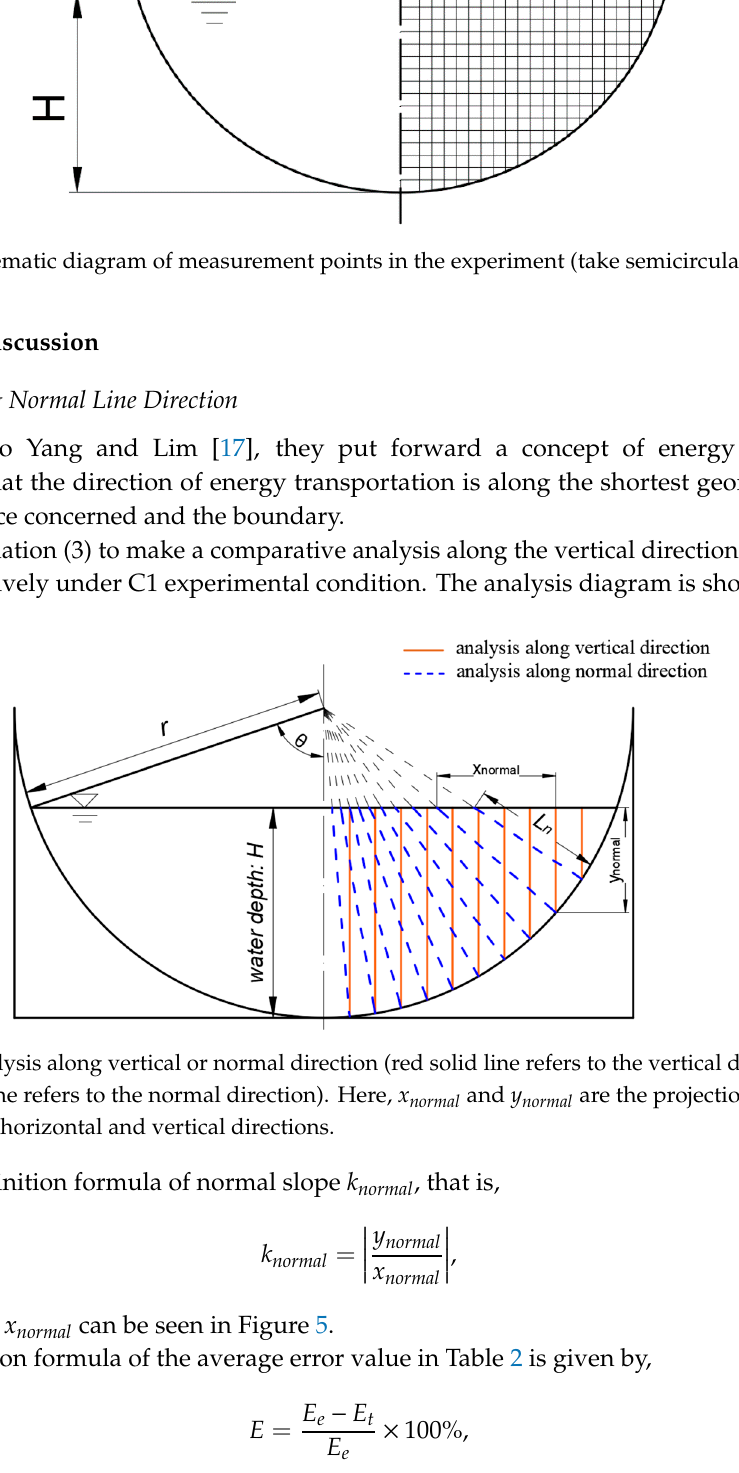
Table 1. Summary of experimental conditions.